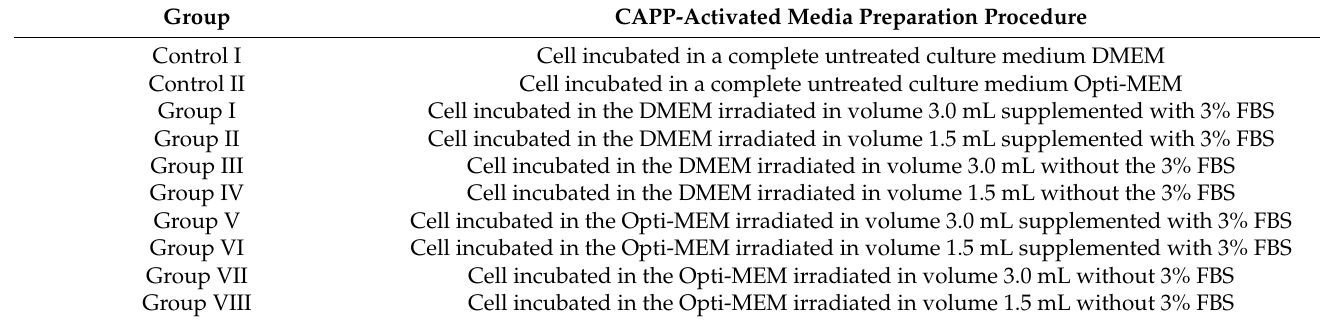
Table 1. The summary of the CAPP-activated media